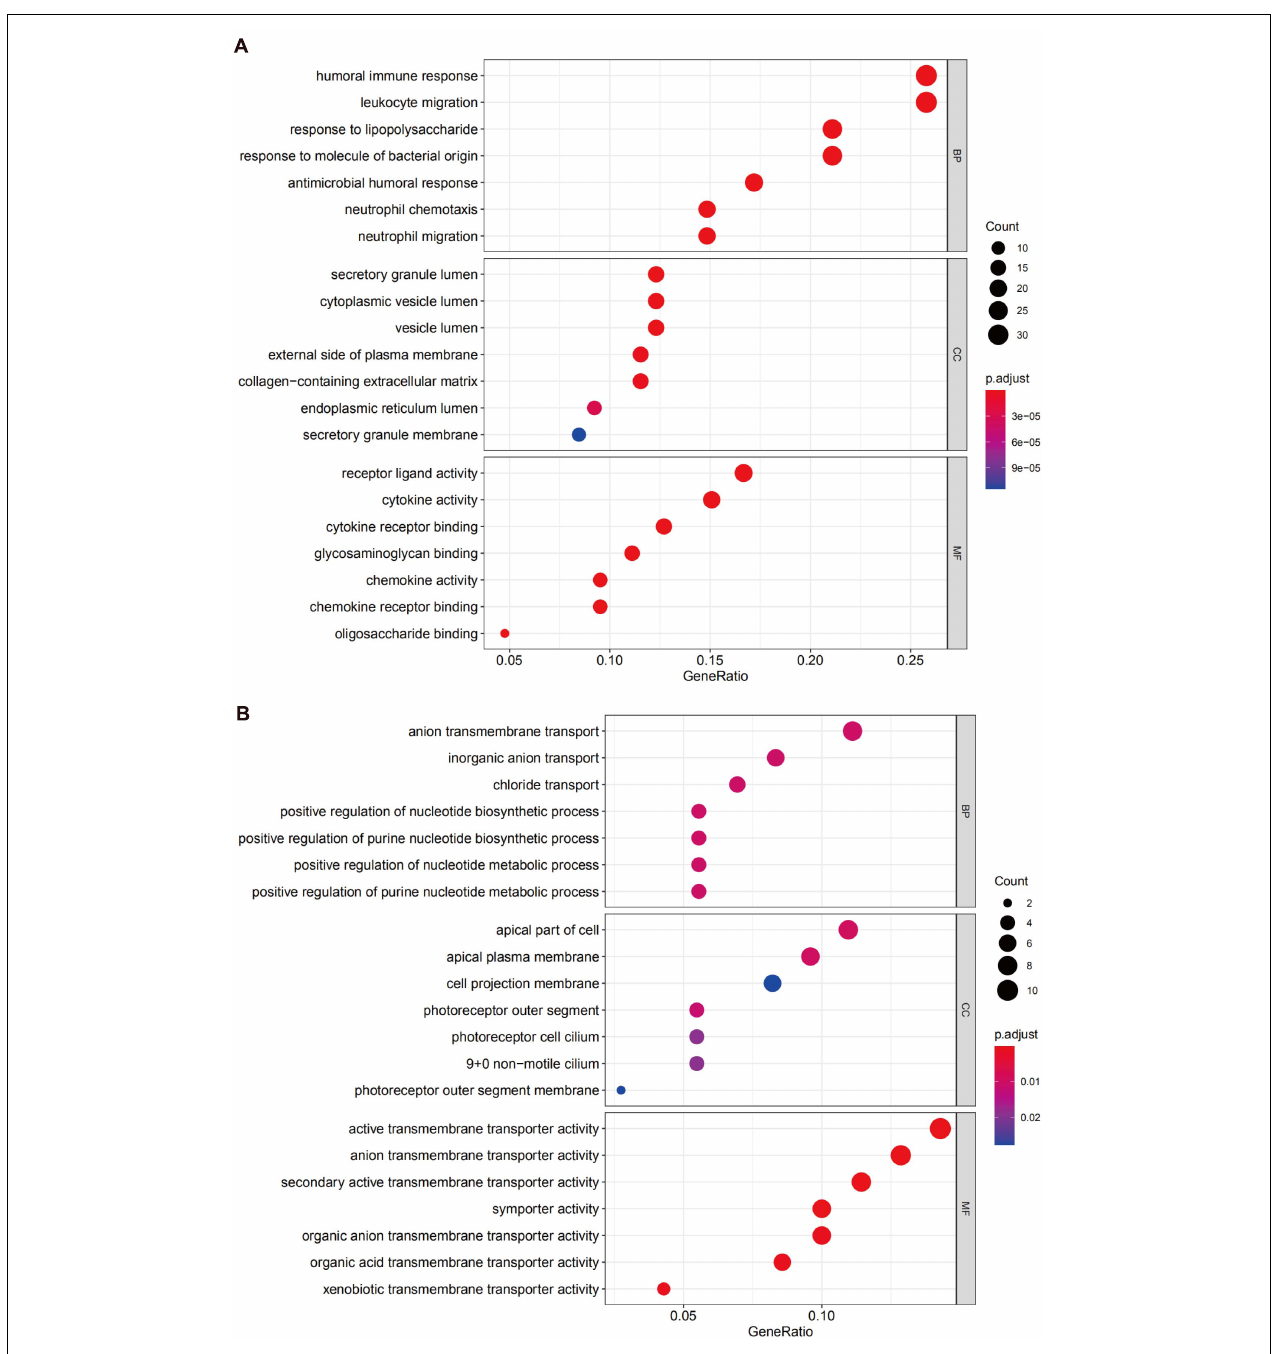
FIGURE 4 | Gene Ontology (GO) analysis of DEGs. (A) Functional enrichment analysis of upregulated genes. (B) Functional enrichment analysis of downregulated